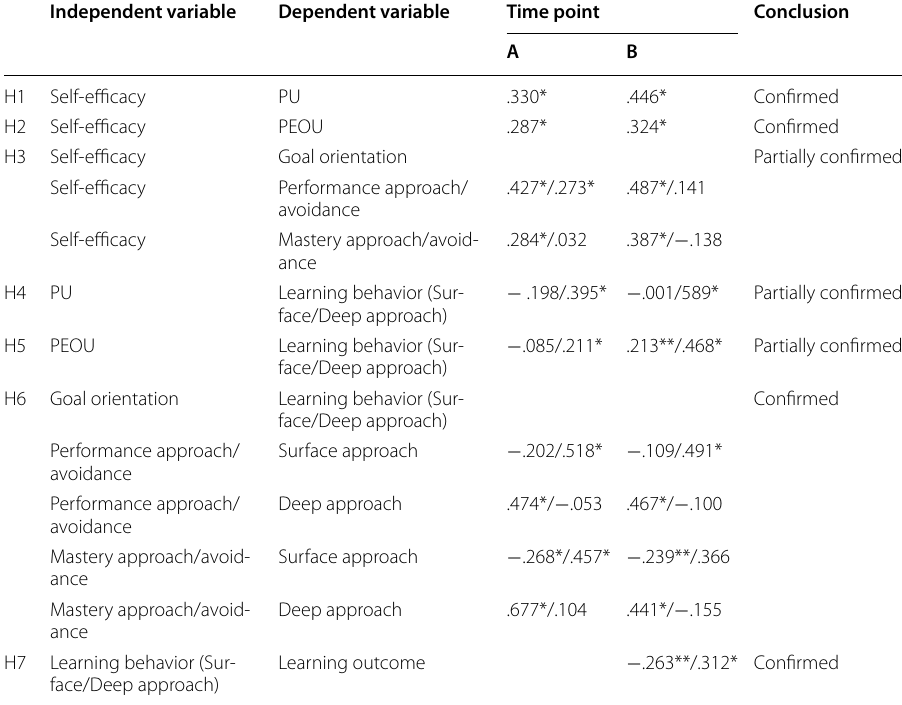
Table 8 Research hypotheses